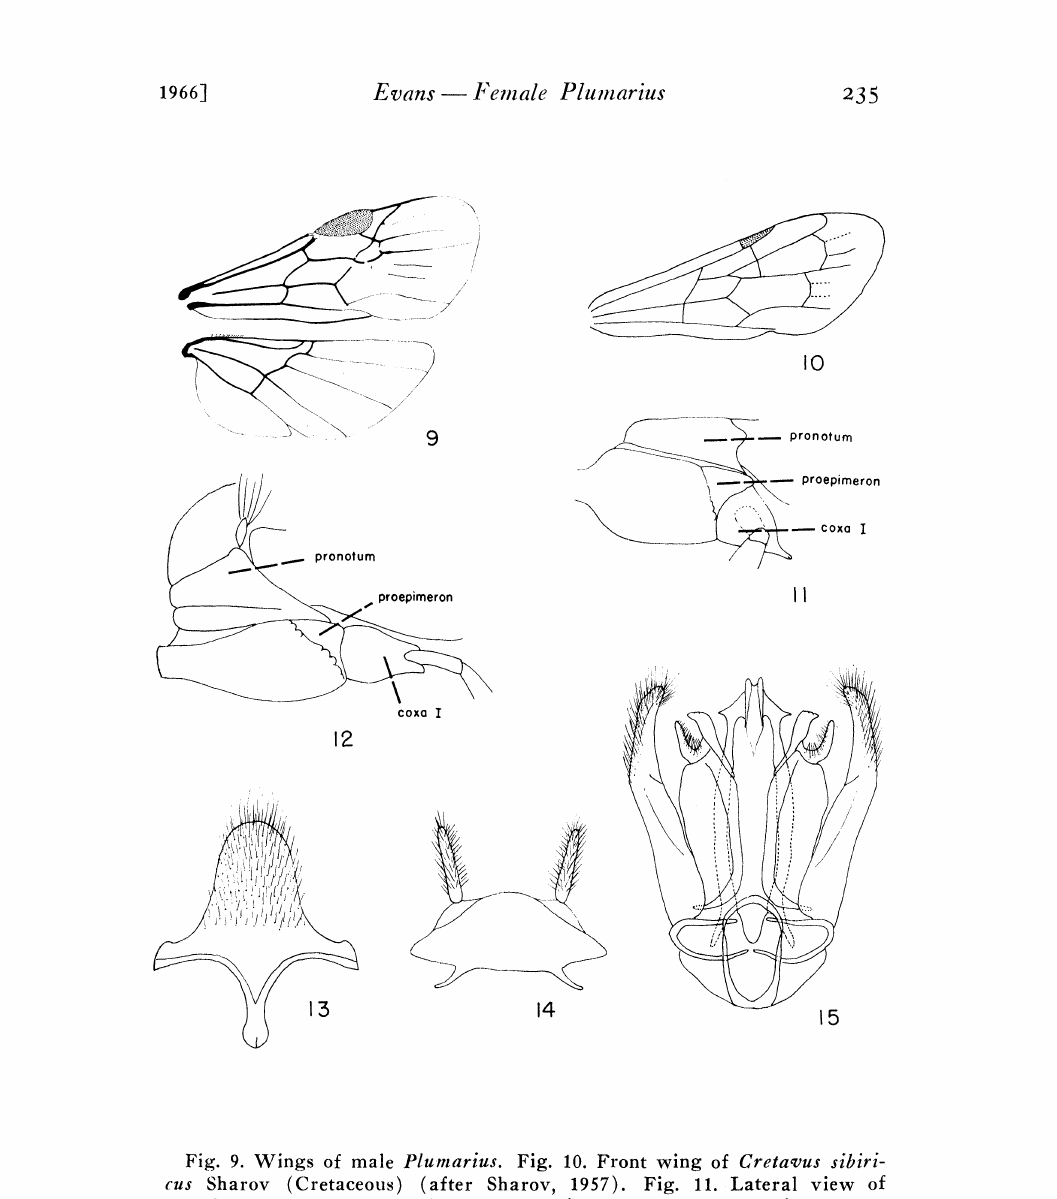
Fig. 9. Wings of male Plumarius. Fig. 10. Front wing of Cretavus sibiri- cus Sharov (Cretaeeous) (after Sharov, 1957). Fig. 11. Lateral view of anterior part of thorax of female Plumarius. Fig. 12. Lateral view of an- terior part o thorax o male Plumarius. Fig. 13. Subgenital plate (meso- somal sternite VIII) of male Plumarius. Fig. 14. Apical tergite (mesosomal tergite VIII) o male Plumarius, showing pygostyles. Fig. 15. Male geni-